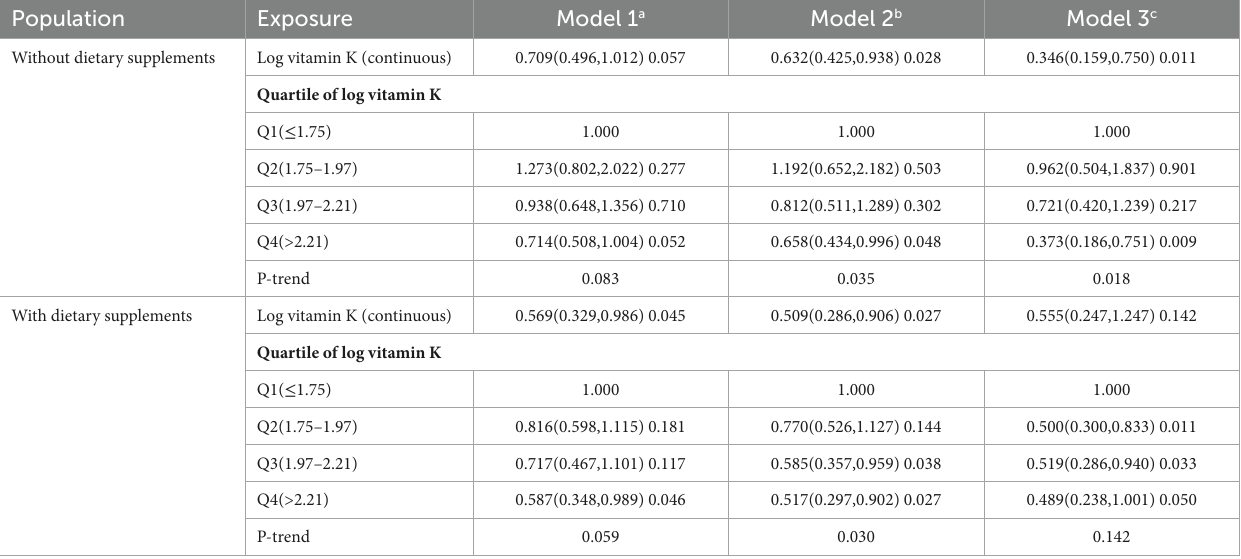
TABLE 3 The relationship of log vitamin K and MAFLD in with or without dietary supplements. Population